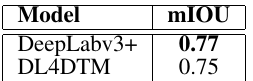
Table 1. mIOU scores for both models on 220